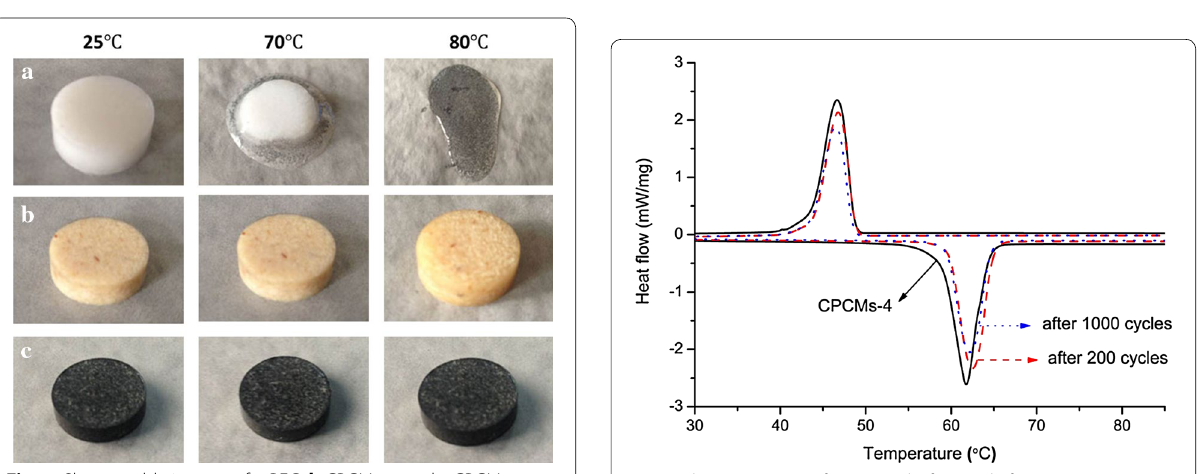
Fig. 8 The DSC curves of CPCMs‑4 before and after experiencing either 200 or 1000 heating–cooling